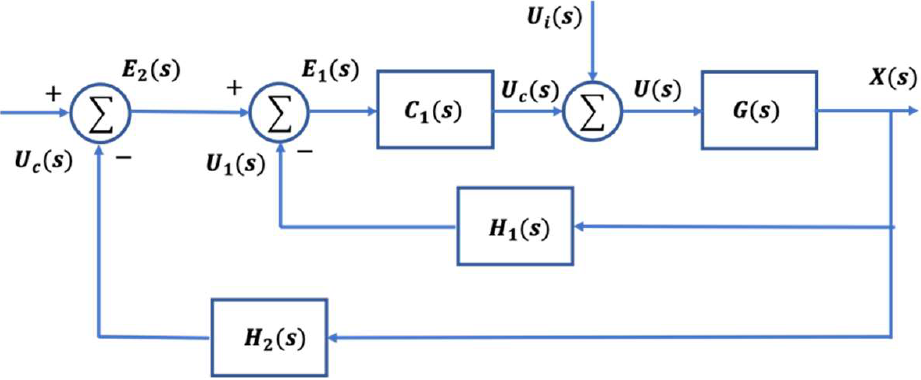
Figure 28. Transform and Control with Arbitrary Initial Conditions.